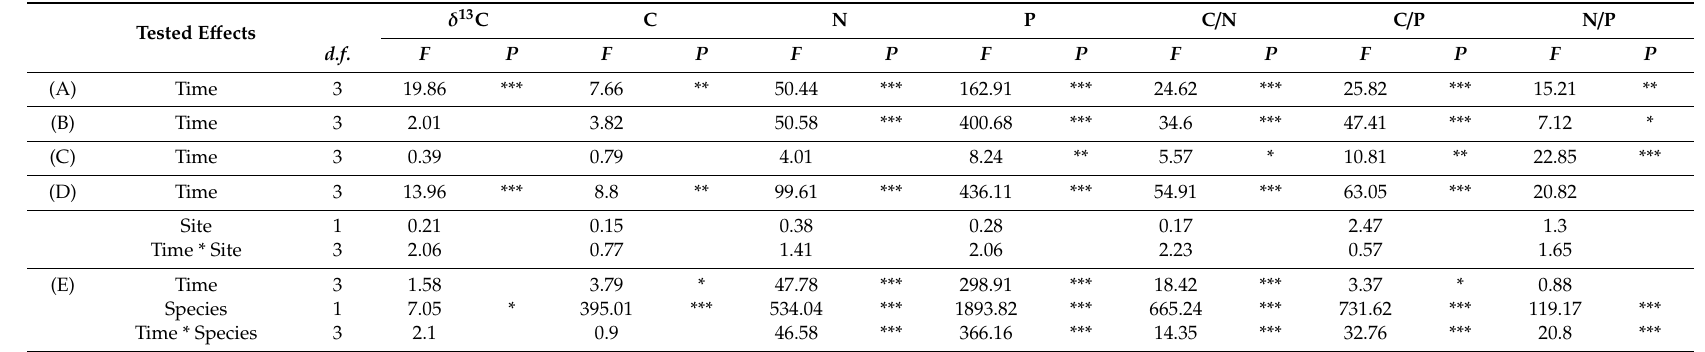
Table 2. Results of a general linear model testing the e ff ects on leaf δ 13 C, leaf nutrient (C, N, and P) concentration, and leaf ratios (C / N, C / P, and N / P). F -values and significance are reported. The results included the following: (A) time e ff ects on the rubber trees in the RM; (B) time e ff ects on the rubber trees in the RS-AFS; (C) time e ff ects on the intercrops in the RS-AFS; (D) the e ff ects of time and site on the rubber trees; and (E) the e ff ects of time and species on the plants in the RS-AFS. “ d.f. ” indicates the degree of freedom, “ F ” indicates F value and “ P ” indicates P value. * p < 0.05, ** p < 0.01, *** p <